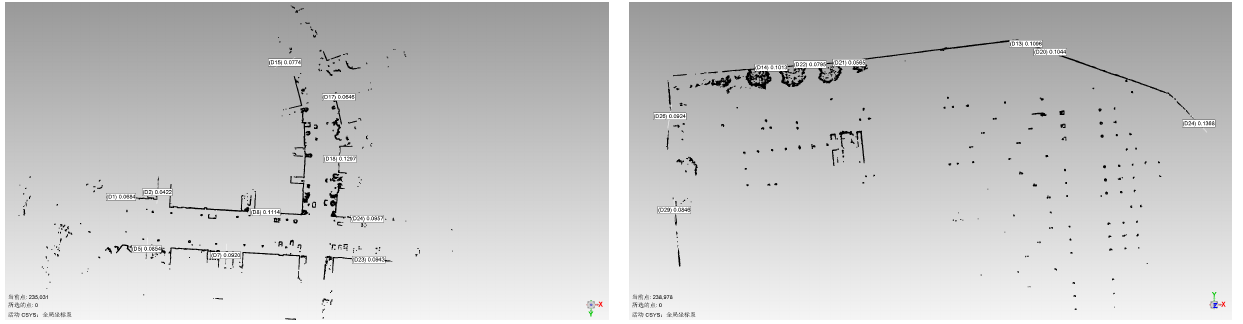
Figure 8. The reconstruction result of kitti dataset. From the Figure 11. The analysis of power site reconstruction from the thickness perceptive, the reconstruction of kitti environment has thickness perceptive. The reconstruct result is suitable for a bettter result. vegetation management.